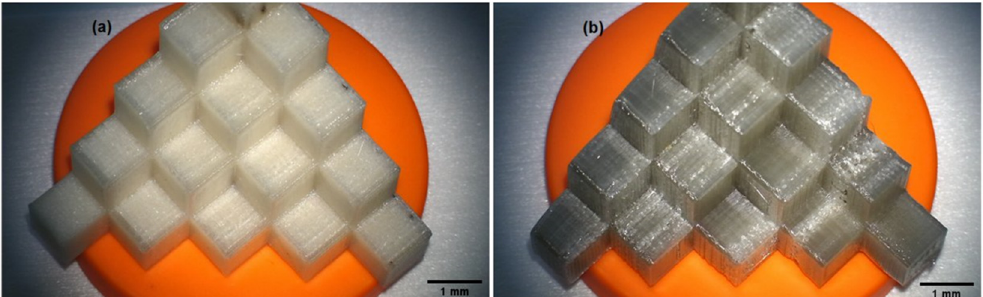
Figure 2. Calibration models printed on the VORON model 2.4 printer. Filament printout: ( a ) mate- rial in the test model with the composition of 700 g PC/5 g PO/3.5 g talc and ( b ) material in the test model with the composition 700 g PC/5 g PO/3.5 g talc, additionally free of water using the ChemLand DZ dryer -3BCII.